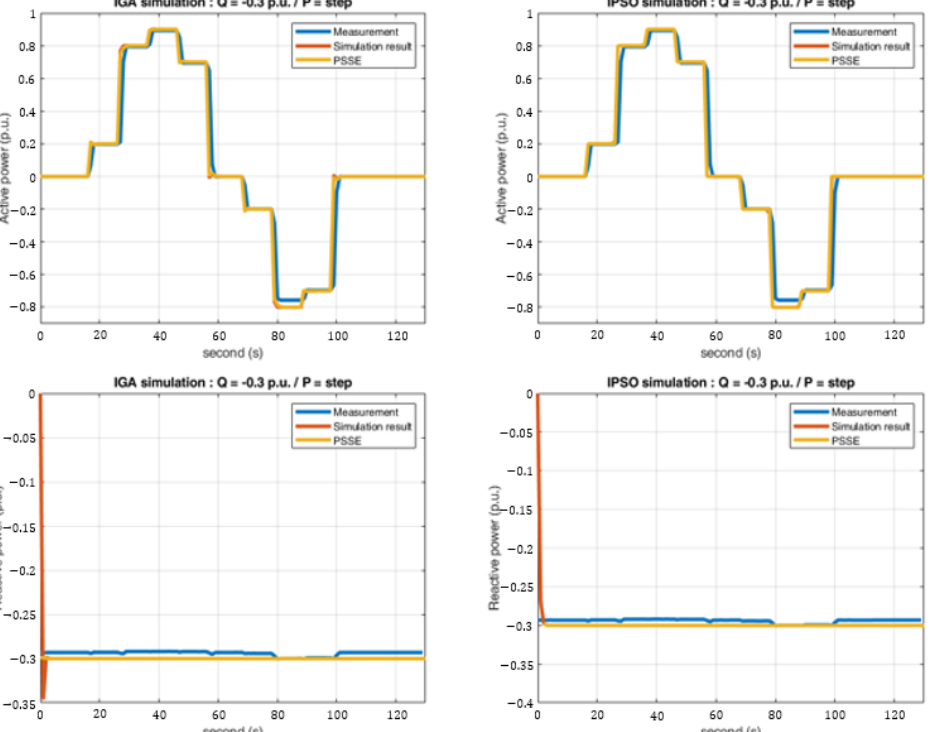
Figure 24. The IGA ( left ) and IPSO ( right ) fitting waveform 2 fitting results .